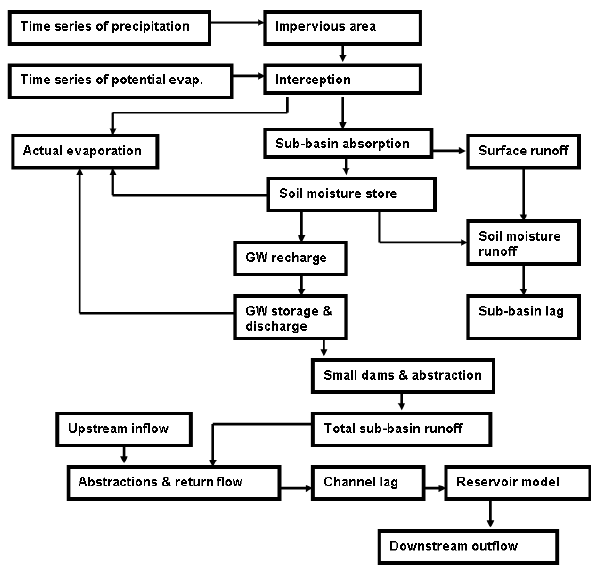
Fig. 4. Flow diagram of the Pitman monthly hydrological